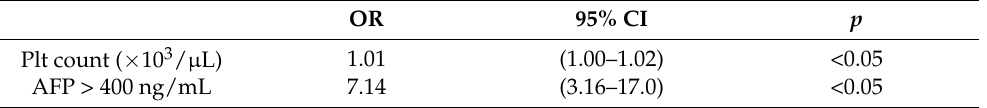
Table 5. Multivariate analysis for pretransplant predictors related to recurrence within 5 years in BM